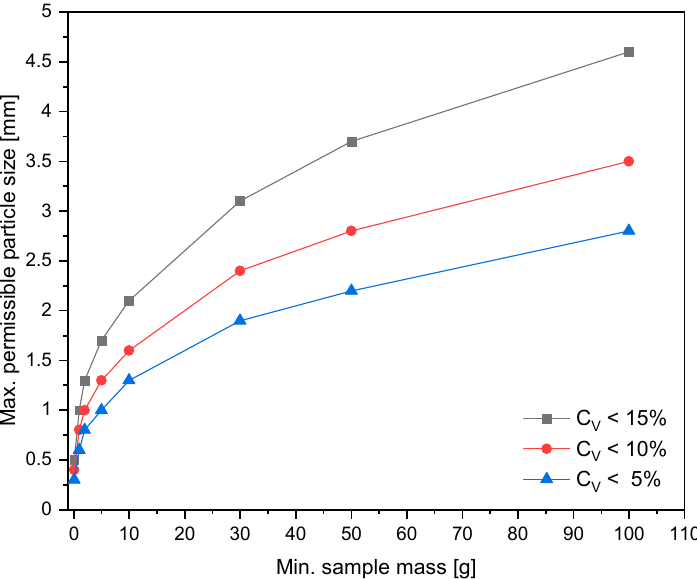
Figure 5. The relationship between the largest particle size and the sample mass with various coefficients of variation (C V ), compiled by the authors based on the table of minimum masses of a laboratory sample in DIN 16011 [71] (own illustration).